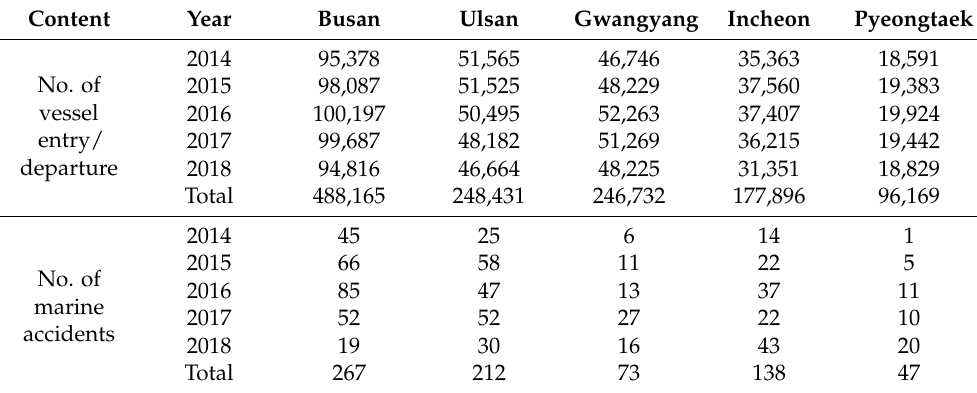
Table 1. Vessel entry/departure and marine accidents by major ports of Korea (2014–2018).